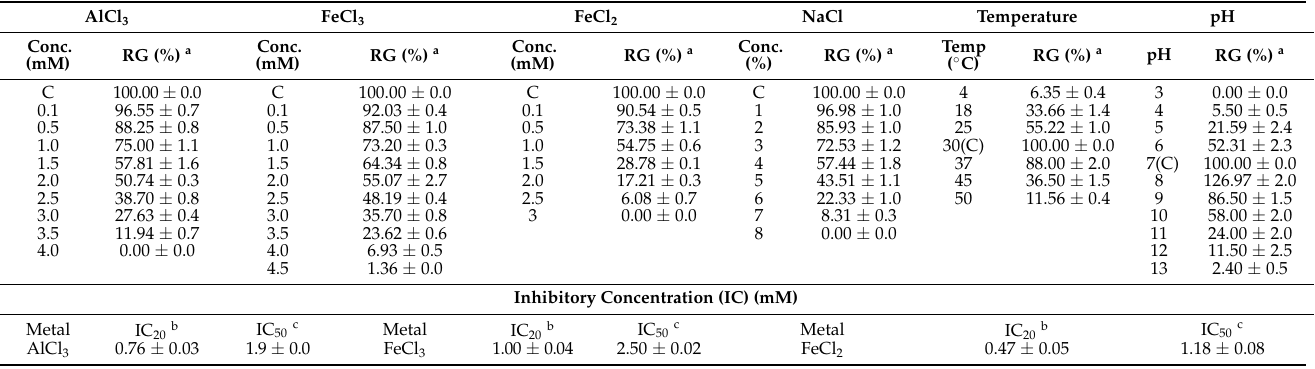
Table 5. Relative growth (RG) of the bacterial strain A7 on different abiotic stress conditions.